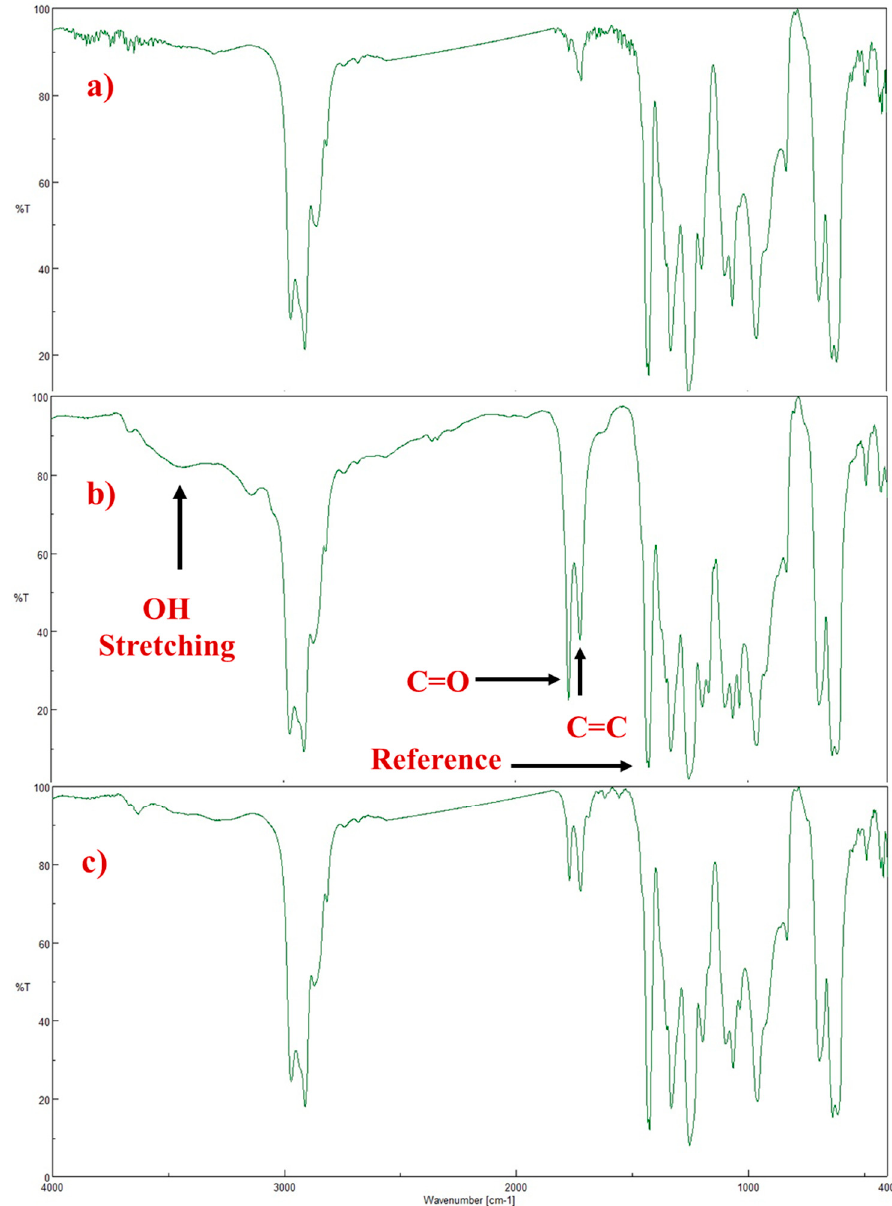
Figure 5. FTIR spectrum of ( a ) blank PVC film before irradiation, ( b ) blank PVC film after irradiation, ( c ) blended PVC film with PVC-ed/p-OH compound after irradiation. Equation (1) was used to calculate the functional group indices of PVC with additives and pure PVC films. They have been determined as the carbonyl index (I C=O ), alkene index (I C=C ), and hydroxyl index (I OH ). The results have been displayed against the irradiation time as shown in Figures 6–8. It was found that the values of the indices of carbonyl, hy- droxyl and alkene increase with the increase in irradiation time through the appearance of the carbonyl and hydroxyl bonds and the double bond developing with the irradiation time. It is noted that this value is low compared to the blank polymer. It was also found that the new polymers behave as good stabilizers against photo fragmentation. All addi- tives have shown reasonable stability for PVC films in comparison to blank PVC. This result matches with the weight loss experiment outcome since the efficiency of additives